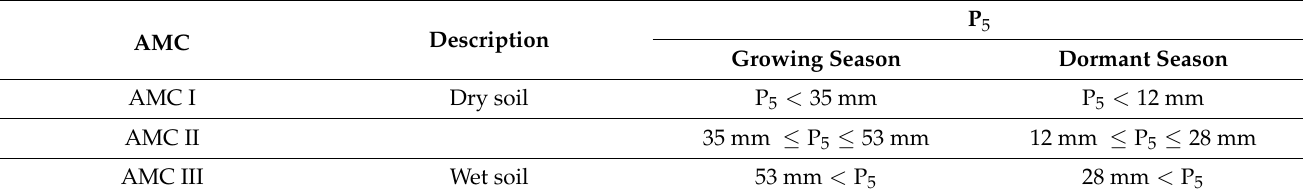
Table 1. Definition of